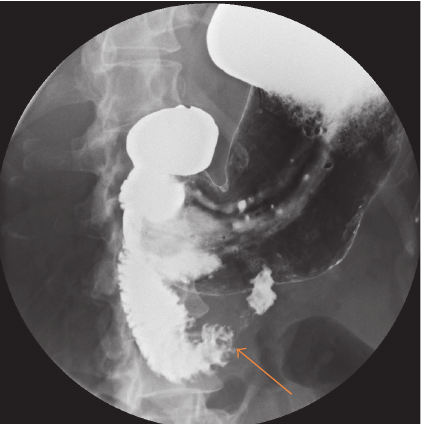
Figure 7: Duodenal compression of the third part (orange arrow) on barium meal and follow through (Case Report Two).